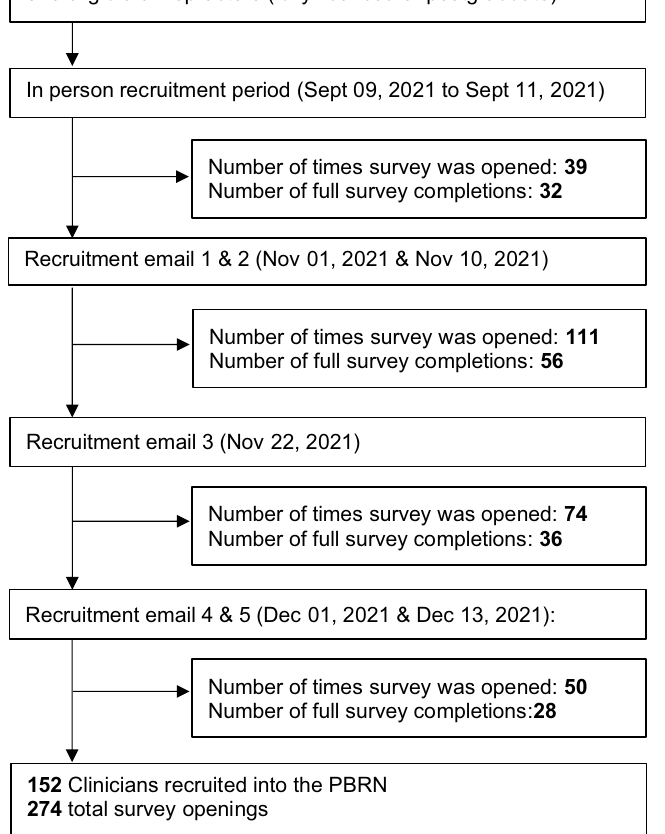
Figure 1. Swiss chiropractic PBRN recruitment flowchart. Dec December, Nov November, PBRN Practice- based research network, Sept